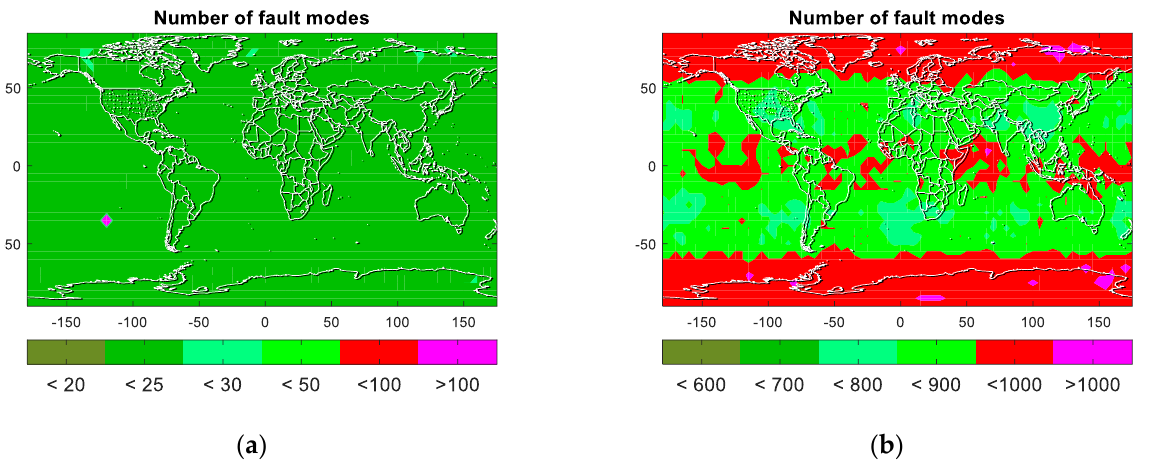
Figure 6. Number of fault modes in ARAIM. ( a ) ARAIM with constellation dynamic selection. ( b ) ARAIM with four constellations.